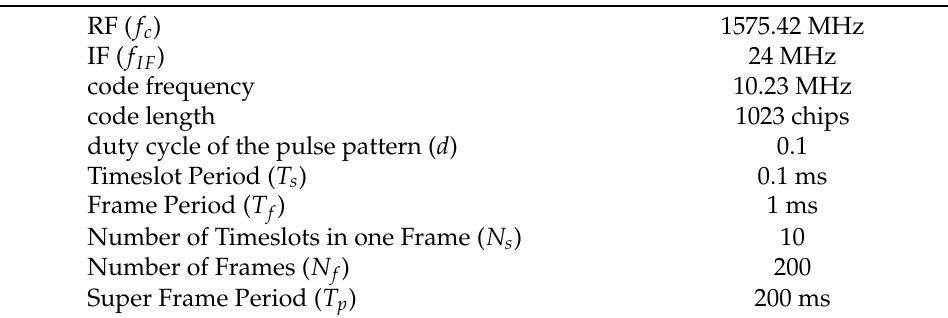
Table 1. Main parameters of PRPS.